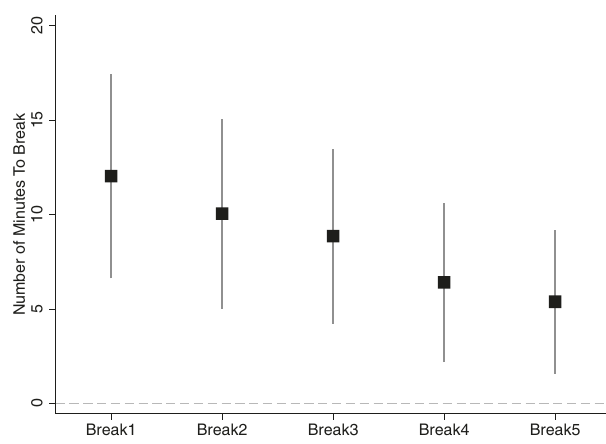
Fig. 1 Treatment effect of cumulative time to breaks. This fi gure shows the treatment effect of being in a forested versus deforested setting on the cumulative time to breaks 1 – 5. The treatment effect is measured in minutes. The bars around the point estimate denote the 95% con fi dence interval using robust standard errors. n = 361. Table 2 Effect of forest treatment on subjective perceptions of the negative effects of heat on productivity. Marginal effects estimated from a multinomial logit regression. The two rows below each coef fi cient report the 95% con fi dence intervals in parenthesis and two-tailed p values, respectively. We denote conventional statistical signi fi